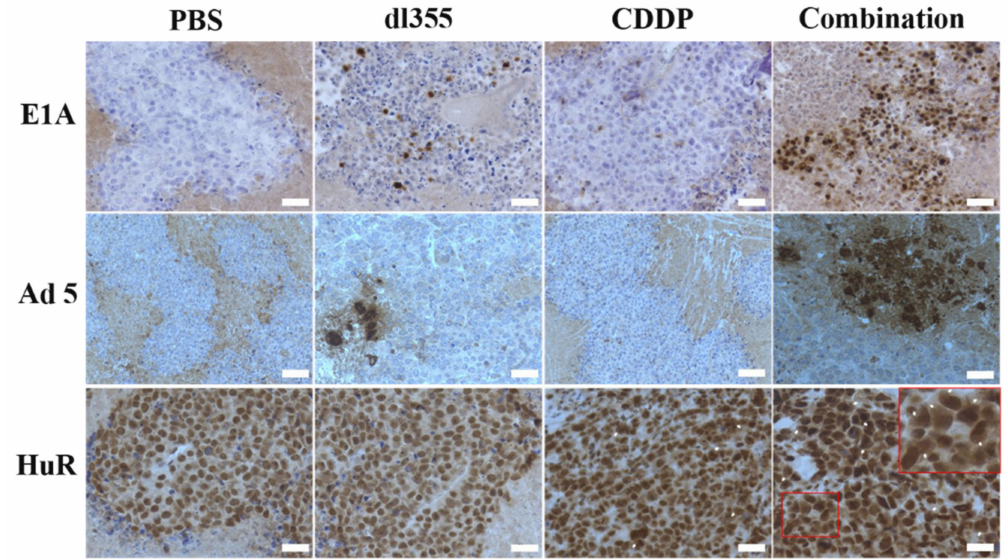
Figure 6. E ff ect of CDDP in virus replication and enhanced cytoplasmic HuR translocation. After fixation and para ffi n processing, tumor specimens were sectioned at 4- µ m thicknesses. The in vivo expression of E1A, Adenovirus type 5 capsid proteins, and HuR in treated and untreated tumors were examined by immunohistochemistry at magnification × 20. Adenovirus-infected cells were stained as brown. Arrow indicates cytoplasmic HuR expression. Inset shows (lower right panel) higher magnification of cytoplasmic HuR expression. Bars, 50 µ